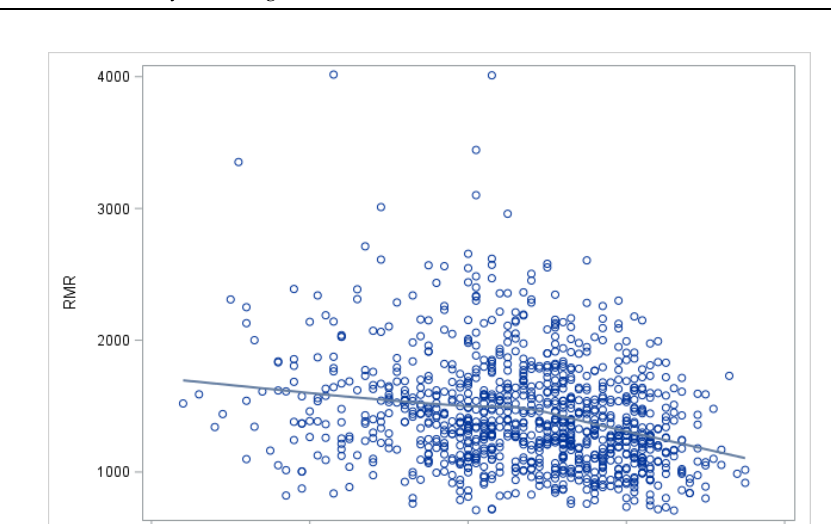
Figure 1. Scatterplot of the cross-sectional association between RMR (kCal/day) and age (years).